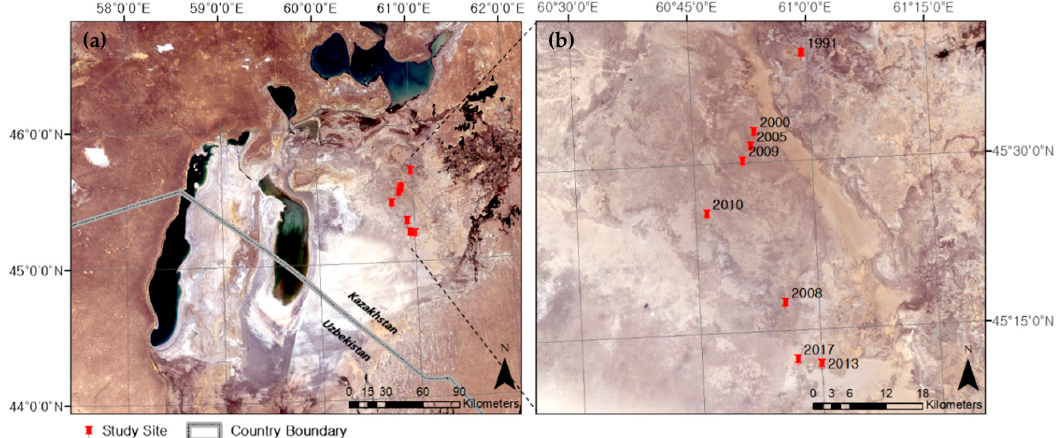
Figure 1. Study area in northern Aralkum, Kazakhstan ( a ) and locations of the surveyed afforestation sites ( b ). Source: Landsat-8 OLI acquired on 17–31 August 2018. WGS 1987 UTM Zone 40N.